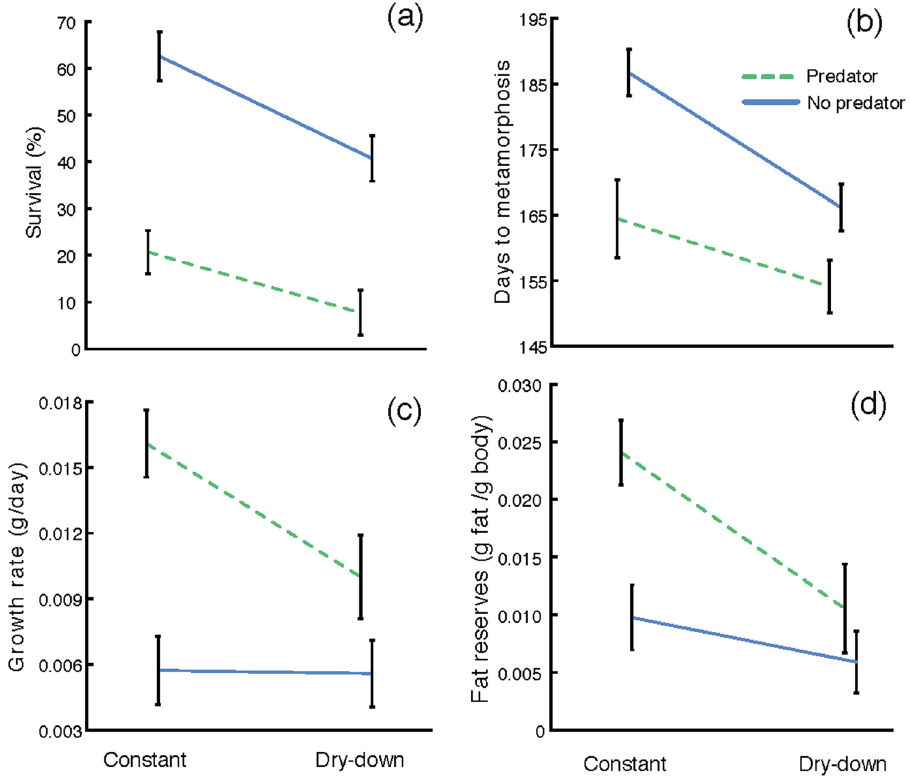
Figure 1. The effect of pond drying and predators on ( a ) survival, ( b ) larval period (days to metamorphosis), ( c ) growth rate, and ( d ) fat reserves in Pelobates cultripes metamorphosing from different larval conditions. Data are least square means ± standard error. The water level regime is indicated as ‘Constant’ and ‘Dry-down’ and the lines indicate the presence (P, green dashed line) or absence (NP, blue solid line) of